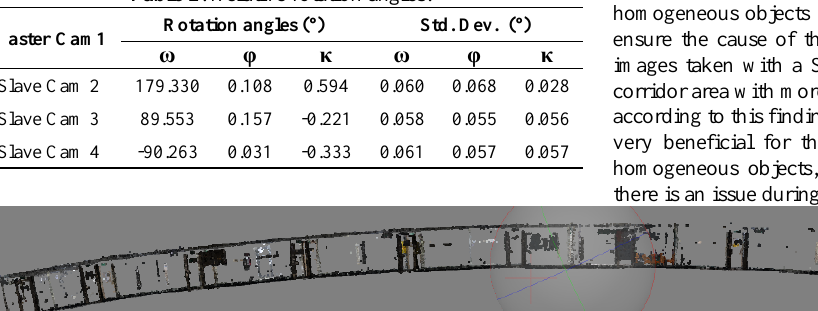
Table 2 . Relative rotation angles.